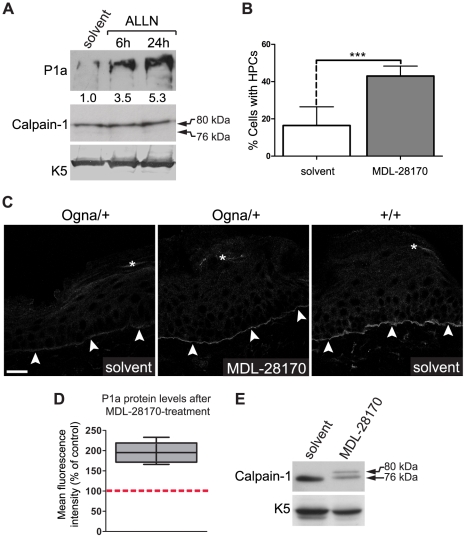
Calpain inhibitors restore P1a expression and HD formation in Ogna keratinocytes and Ogna mice.(A) Immunoblotting of cell lysates from primary PlecOgna/Ogna keratinocytes grown to ∼70% confluence in KGM/0.3, and exposed to either DMSO (solvent) alone, or calpain inhibitor ALLN (10 µM) for up to 24 hours. Note, samples analyzed contained equal amounts of calpain-1 and K5. Numbers below lanes represent protein ratios relative to an arbitrary level of 1.0 assigned to the control (solvent) sample. One of three experiments is shown. (B) Primary PlecOgna/Ogna keratinocytes grown as in (A) were exposed to DMSO (solvent) alone, or calpain inhibitor MDL-28170 (50 µM) for 48 hours. The bar diagram shows proportions (%) of solvent- and MDL-28170-treated cells having formed HPCs. Data shown represent mean values of cell counts (>500/genotype) in randomly chosen optical fields from three independent experiments ±95% CI. *** P<0.001, unpaired Student's t-test. (C) Visualization of P1a on frozen sections of mouse tail skin using P1a-specific antibodies. Note that in tail skin of PlecOgna/+ mice treated with MDL-28170 there was a clear increase in P1a levels compared to mice treated with DMSO (solvent) only; even though the restored P1a levels did not reach the levels of Plec+/+ controls. Arrowheads, basal cell membrane of basal keratinocytes. Bar, 20 µm. (D) Semiquantitative confocal microscopy analysis (n = 5 per group) of P1a levels in MDL-28170- relative to DMSO (solvent)-treated samples (100%, red broken line) using identical image settings. Note that the mean intensities of P1a fluorescence signals had increased ∼2-fold (compared with untreated skin) after treating PlecOgna/+ mice for 5 days with MDL-28170. Box and whisker plot as in Figure 2. P<0.01, unpaired Student's t test. (E) Immunoblotting of tissue extracts prepared from tail skin epidermis using antibodies to calpain-1. Note partial inhibition of autoproteolytic calpain-1 cleavage upon topical treatment of PlecOgna/+ mouse tails with MDL-28170.